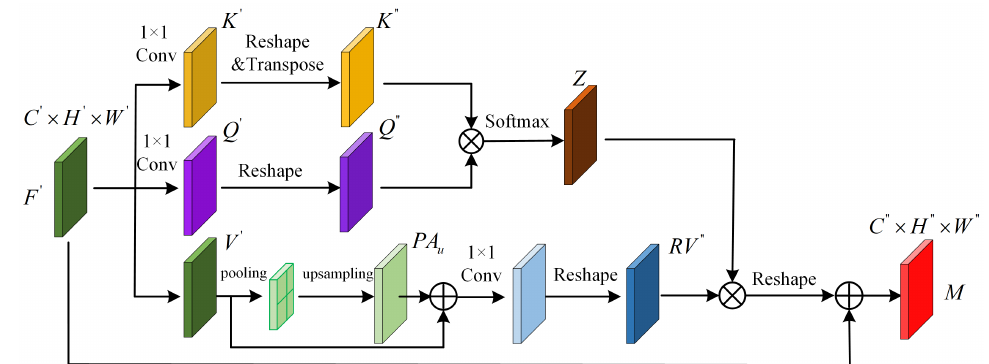
Figure 3. Flowchart of the proposed